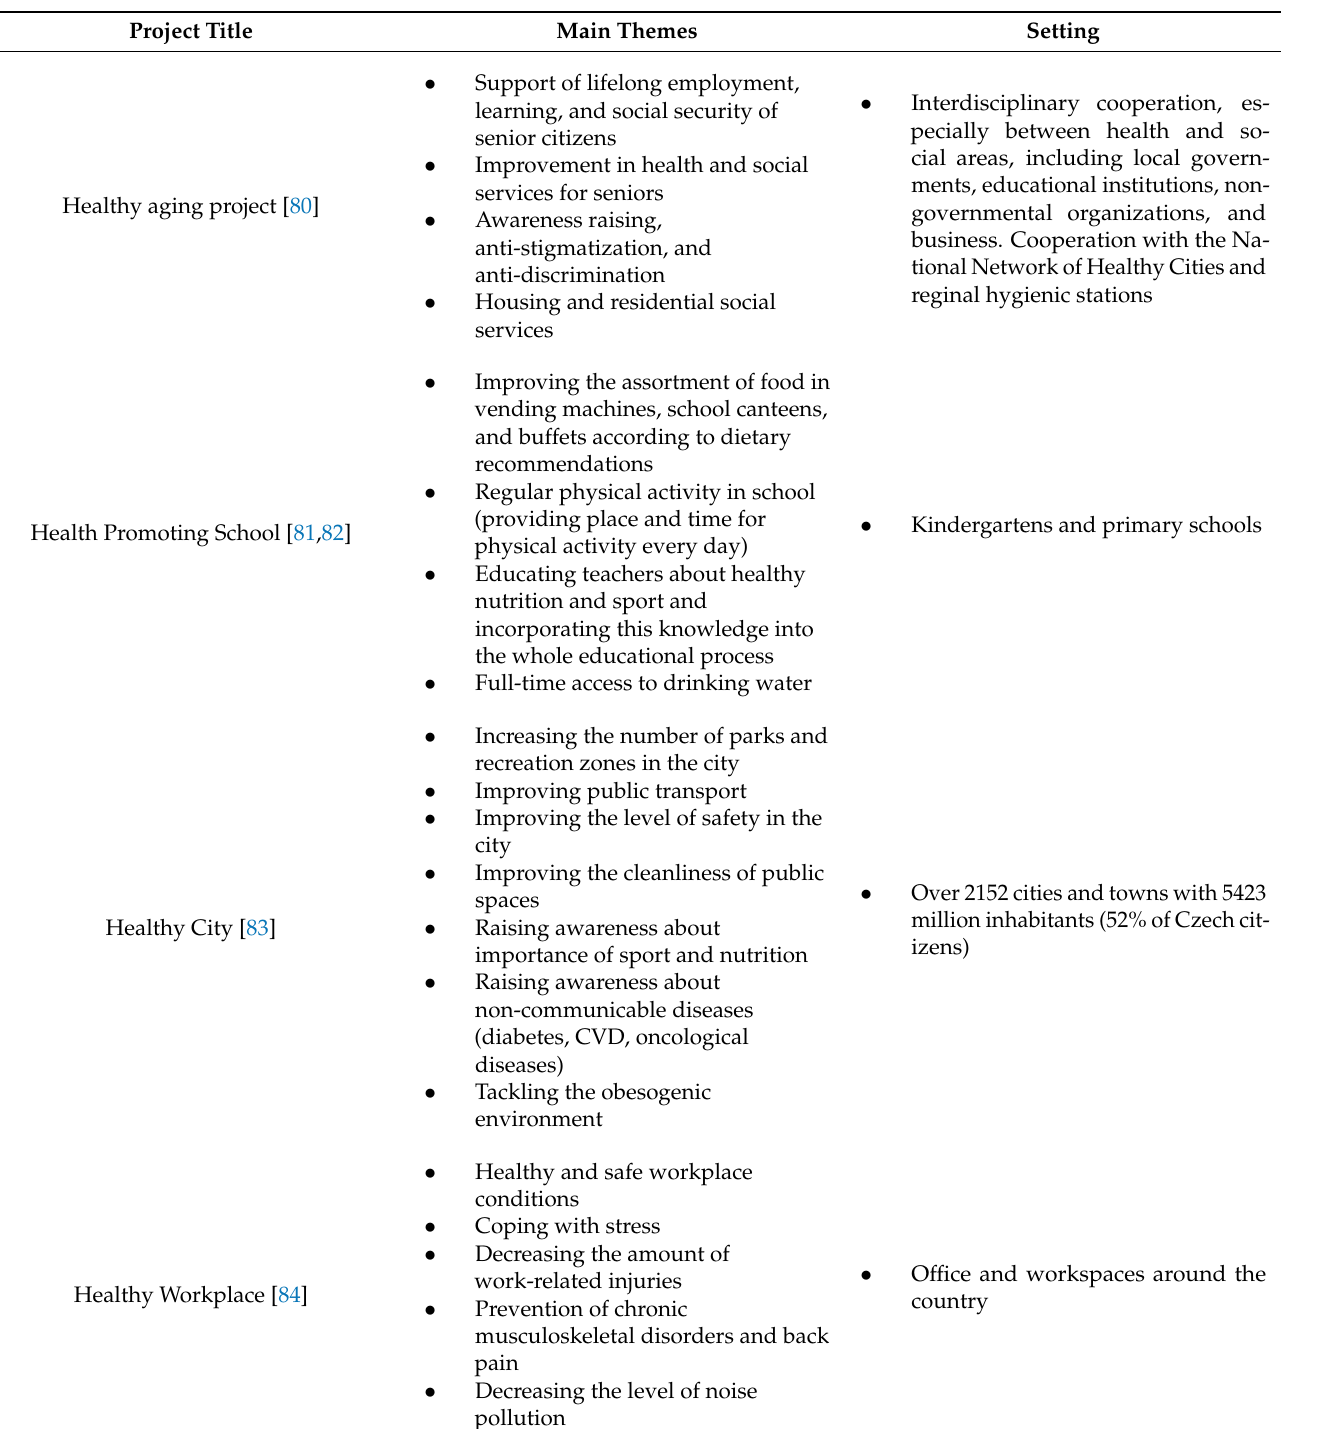
Table 4. Health promotion in Czechia